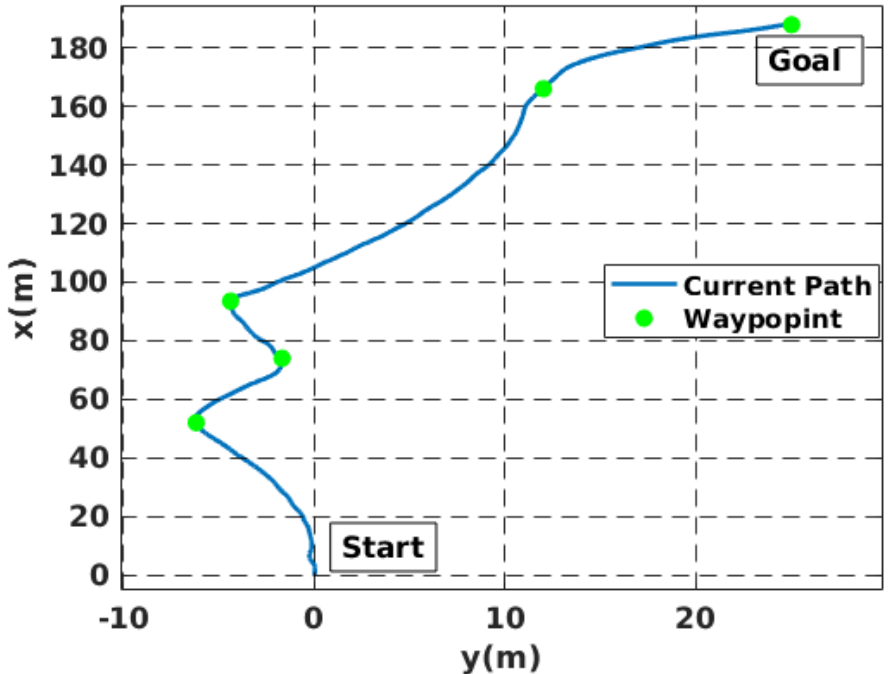
Figure 14. The followed path by the robot while avoiding obstacles in real-world